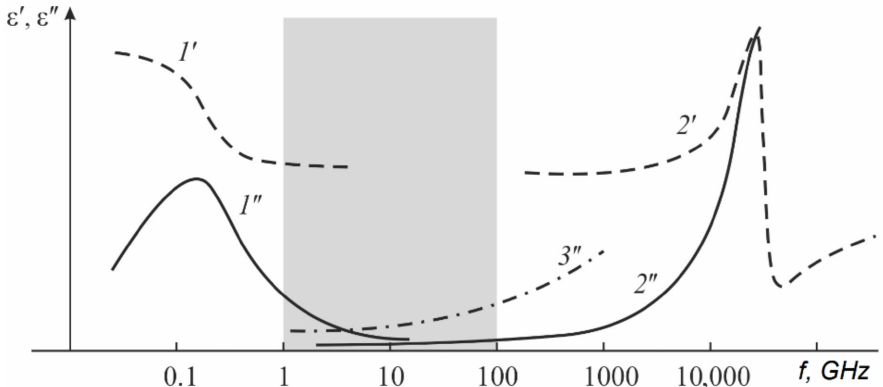
Figure 3. Frequency dependence of permittivity ε (cid:48) (dotted lines) and loss factor ε ” (hard lines) for typical relaxation (1 (cid:48) , 1”) and typical resonance (2 (cid:48) , 2”) dielectric spectra; the gigahertz range is darkened, and curve 3” shows the loss of the polar dielectric